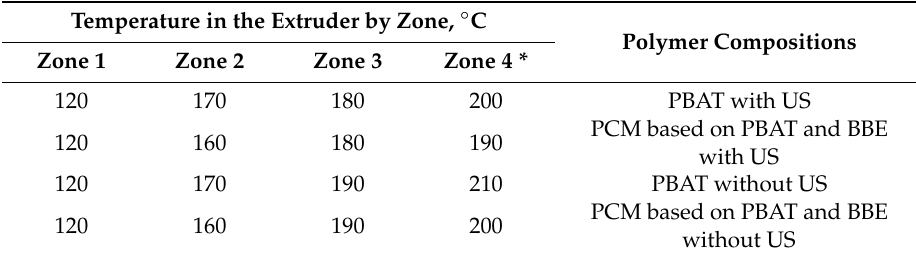
Table 2. Temperature conditions for processing PCM in the extruder ( d = 12